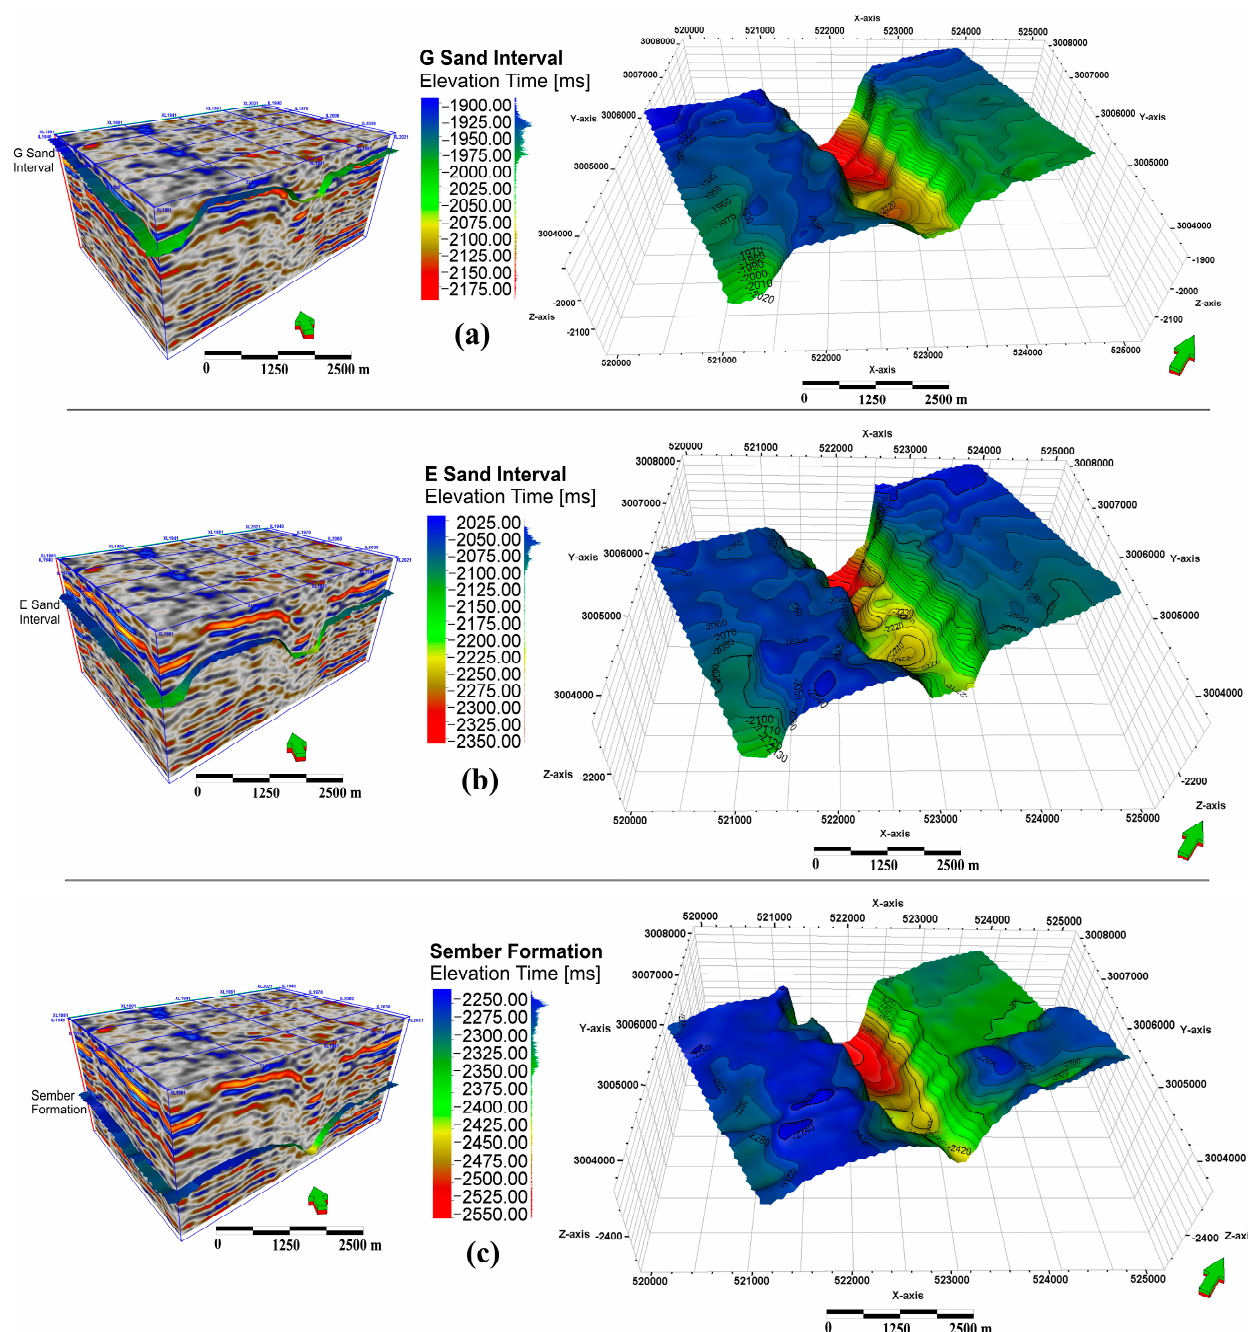
Figure 7. Three-dimensional TWT contour surfaces of the stratigraphic interfaces show different structural distributions: ( a ) TWT top surface of the G sand interval; ( b ) TWT top surface of the E sand interval; ( c ) TWT top surface of the Sembar formation in 3D space.